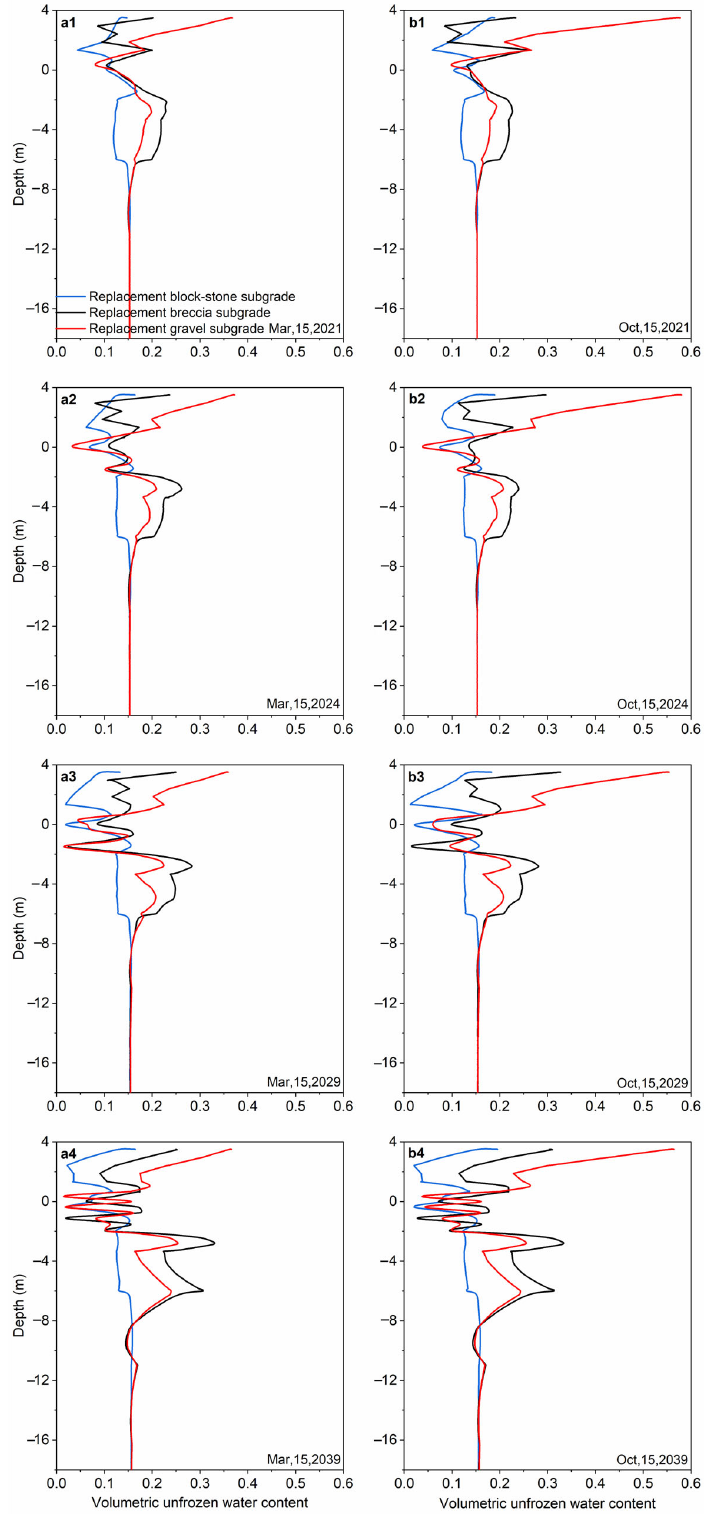
Figure 14. In Case 2, comparison of the vertical distributions of the volumetric liquid water contents under the road centerlines of the three subgrade structures in cold seasons and warm seasons in different years: ( a1 – a4 ) in cold seasons and ( b1 – b4 ) in warm seasons.